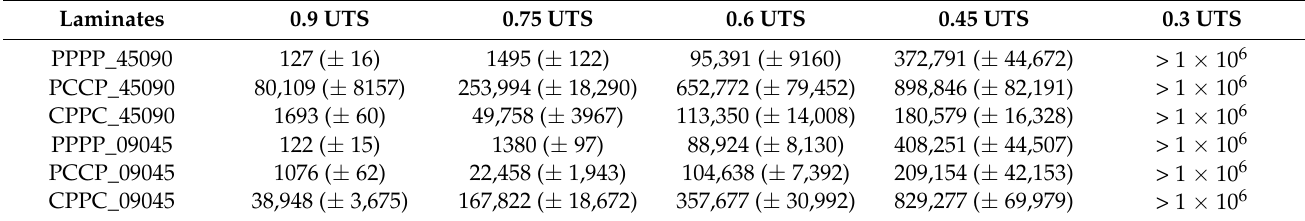
Table 5. Average number of cycles as a function of the UTS ratio. The standard deviations are presented in brackets. Laminates